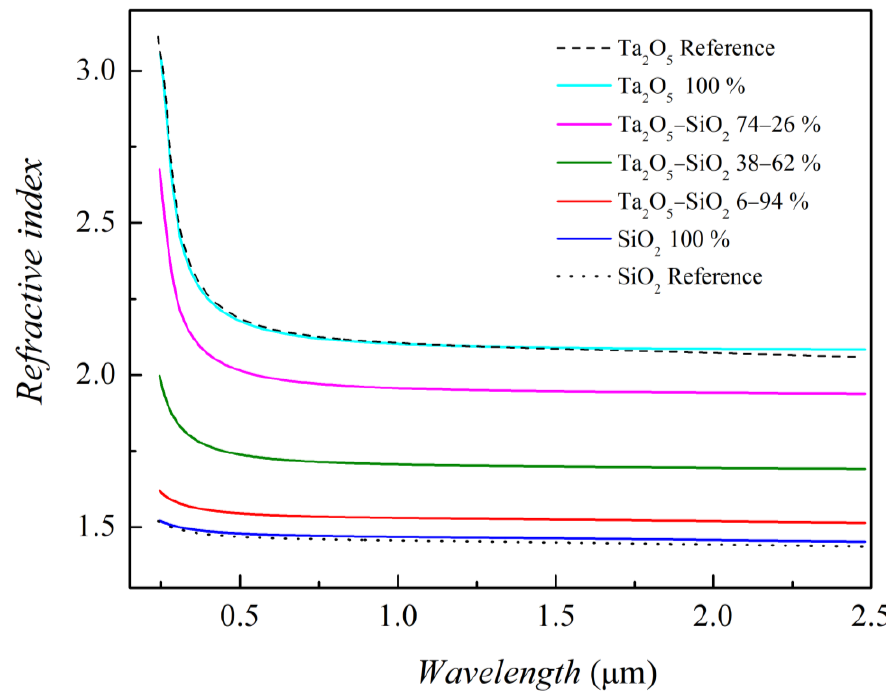
Figure 7. Refractive index spectra on Ta 2 O 5 /SiO 2 mixed oxide samples. Ta 2 O 5 and SiO 2 reference curves were obtained from WVASE32 ® Database by J.A. Woollam Co. Inc.